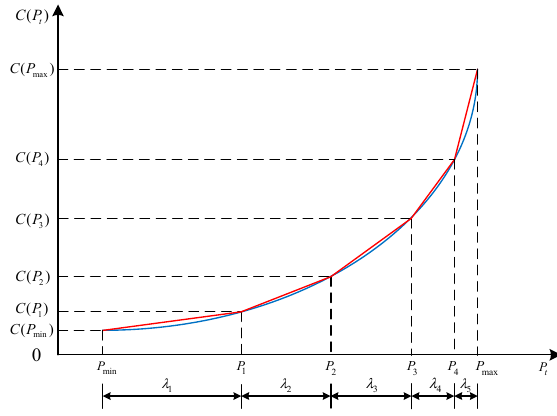
Figure 8. Piecewise linear generation cost of DG units.